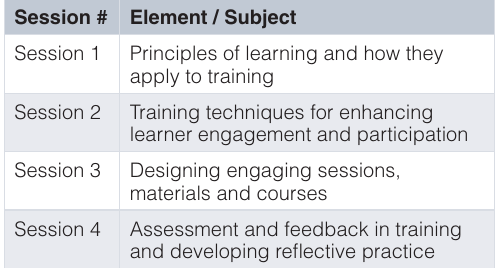
Table 1. Core sessions of the EE-TtT courses. The EE-TtT pilot courses, as well as the training materials, are structured in four main sessions. The four sessions allow for flexibility in the mode of delivery and personalisation from the